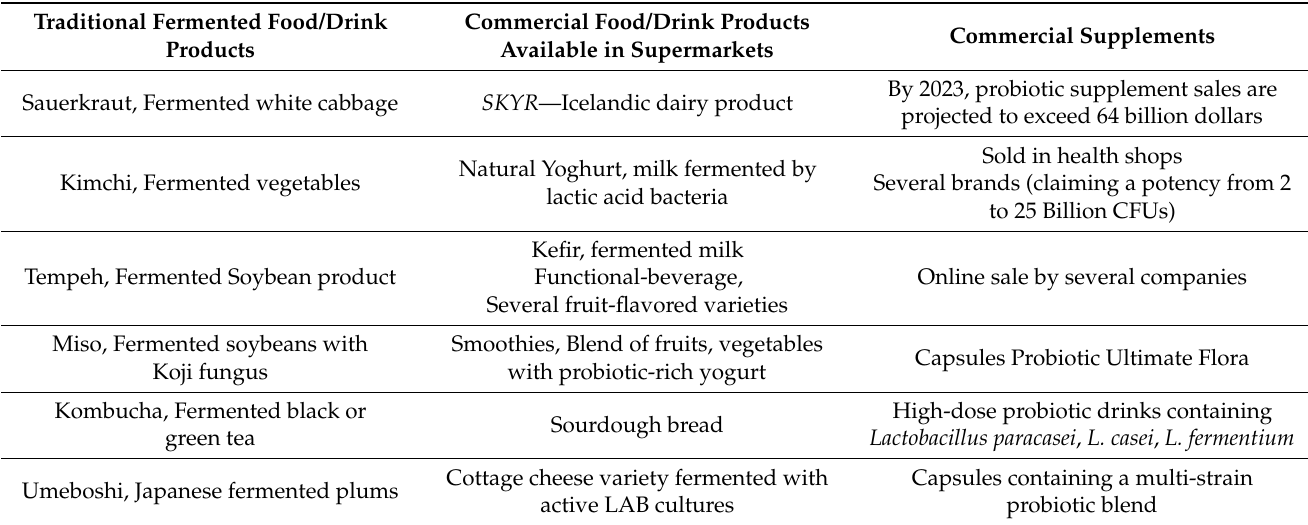
Table 3. Sources of probiotics to influence the gut microbiota for use according to consumers’ personal choice